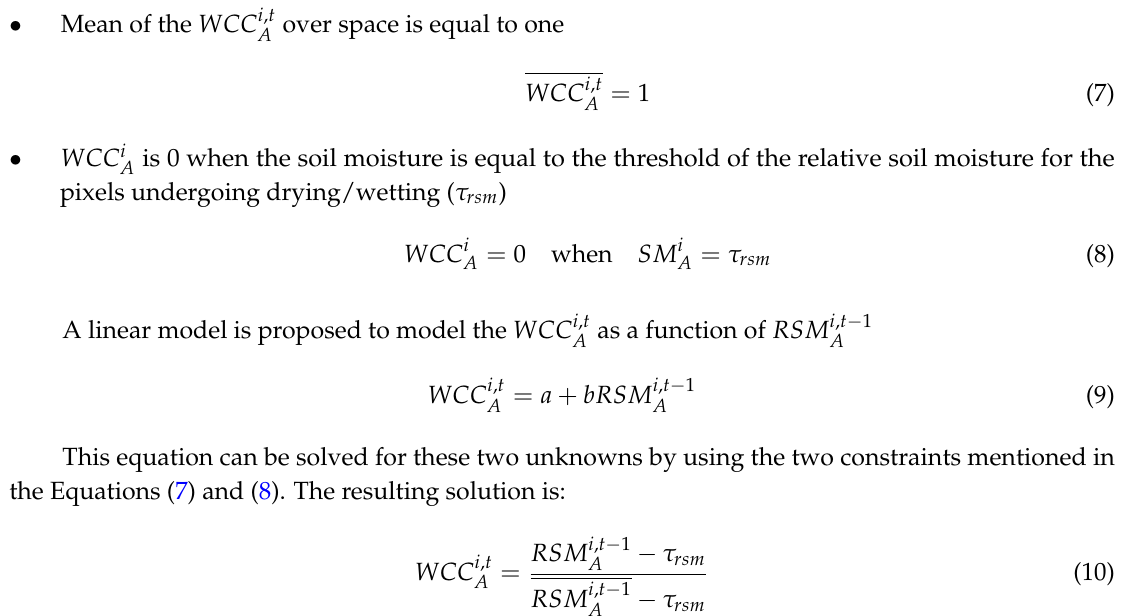
− SM t − 1 ) for three different k P P